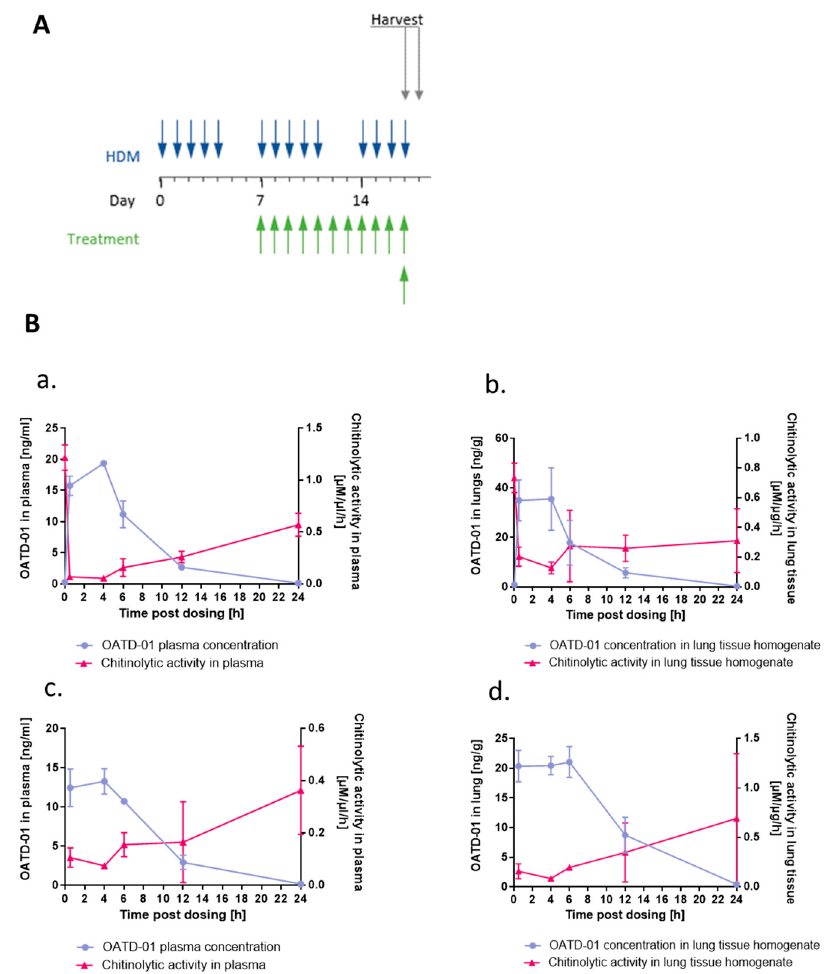
Figure 4. OATD-01 decreases chitinolytic activity in BAL fluid and plasma in a dose-dependent manner. ( A ) Schematic representation of PK/PD study in 3-week-long HDM model with two OATD-01 administration regimens (single dose at 30 mg/kg or 14 day). Blue arrows indicated HDM instal- lations while green OATD-01 treatment. ( B ) Graphs showing relation between chitinolytic activity (magenta) and OATD-01 concentration (blue) in plasma ( a , c ) and lung homogenates ( b , d ) following single dose of OATD-01 at 30 mg/kg on the last day of the study ( c , d ) or multiple administrations of OATD-01 at 30 mg/kg once a day ( a , b ).